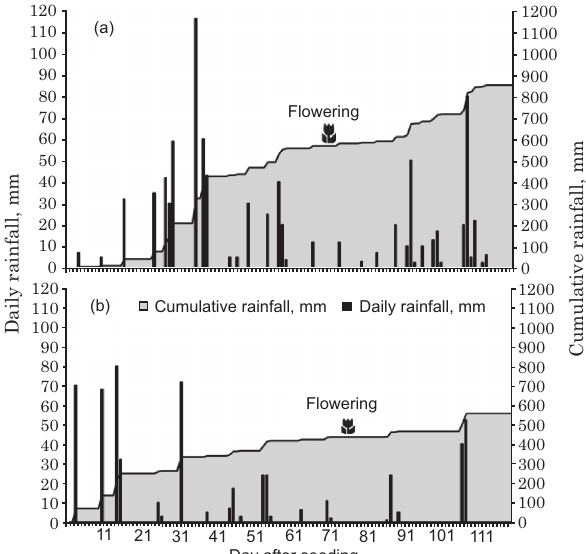
(1) Evaluated by densimetry; (2) Soil organic matter: evaluated by Walkley-Black; (3) extracted by Mehlich-1; (4) extracted by KCl (1 mol L -1 ); (5) cation exchange